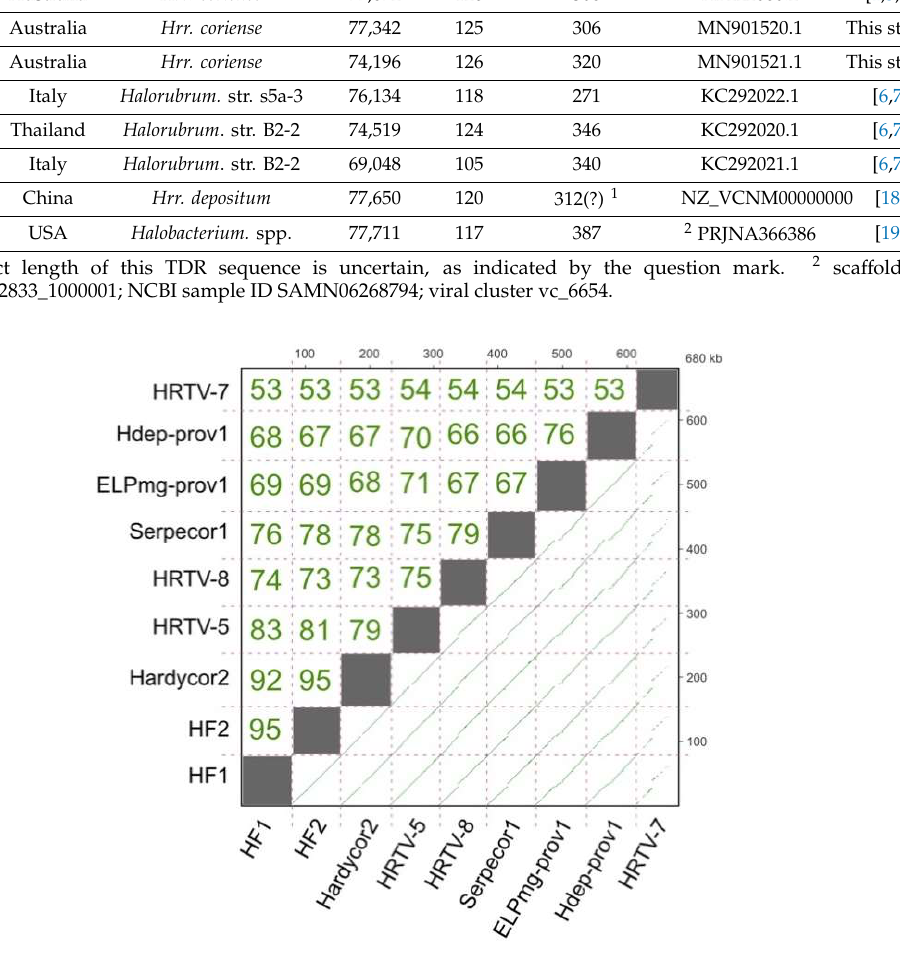
Table 2. Characteristics of HF1-like viruses.